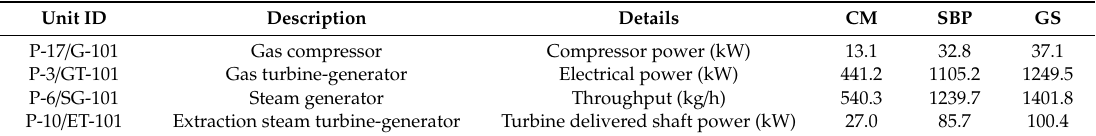
Table 4. Main parameters used for modeling the CHP unit used in the feedstocks CM, SBP, and